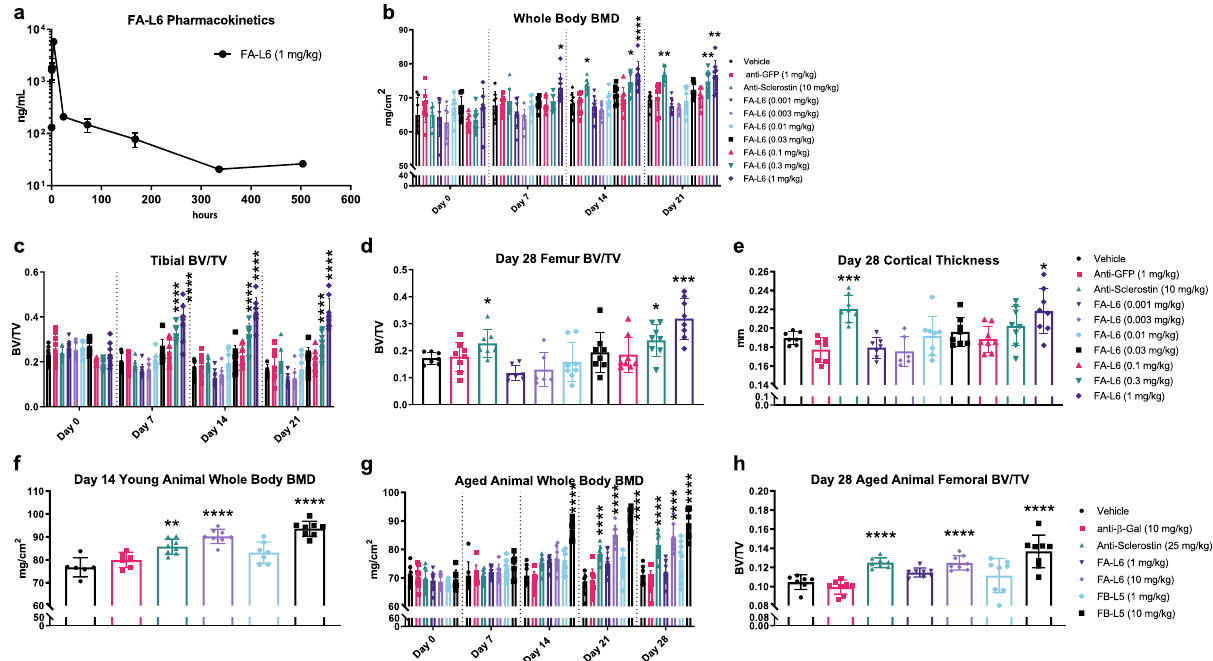
Fig. 5 Wnt mimetic antibodies robustly stimulate bone accrual in naive young and older mice. a Serum concentrations of FA-L6 antibody after intraperitoneal administration, as measured by ELISA over a 21-day period. Each time point represents the average assessed in three animals, with error bars representing the standard deviation of the mean. b – e 8-week-old C57BL6/J female mice were injected bi-weekly for 28 days intraperitoneally with increasing concentrations of FA-L6 antibody and compared to a negative control antibody (anti-GFP IgG 1mg/kg), and a positive control (bi-weekly subcutaneous administration of 10mg/kg anti-sclerostin antibody). b Longitudinal DEXA measurements of whole-body BMD quanti fi ed for days 0, 7, 14, and 21. c Longitudinal micro-CT of proximal tibial bone volume/tissue volume (BV/TV) quanti fi ed on days 0, 7, 14, and 21. d Endpoint distal femoral BV/TV and e mid-shaft cortical thickness were quanti fi ed at day 28. f Whole-body BMD by DEXA in 16-week-old C57BL6/J female mice injected bi-weekly for 14 days with FA-L6 (10mg/kg) or FB-L5 (1 or 10mg/kg) antibody, or a negative control antibody (anti- β -gal 10 mg/kg), or positive control (anti-sclerostin antibody 25mg/kg). g , h 1-year-old C57BL6/J female mice were injected bi-weekly for 28 days intraperitoneally with 1 and 10mg/kg of FA-L6 or FB-L5 antibody or a negative control antibody (anti- β -gal) or positive control (bi-weekly subcutaneous administration of 25mg/kg anti-sclerostin antibody). g Longitudinal whole-body BMD over time and h day 28 endpoint distal femoral BV/TV measurements are shown. a Graph represents mean ± SD, n = 3 mice. b – h Bar graphs represent mean values ± SD. Statistical signi fi cance was determined by two-way ANOVA for b , c , g and one-way ANOVA for all others (* p < 0.05, ** p < 0.01, *** p < 0.001, **** p < 0.0001) where the following letters de fi ne groups (a = Vehicle, b = Anti-Sclerostin, c = FA-L6 (0.3mg/kg), d = FA-L6 (1mg/kg), e = FA-L6 (10mg/kg), f = FB-L5 (10mg/kg)). b Day 7, a vs. d, p = 0.041; Day 14, a vs. b, p = 0.032, a vs. c, p = 0.0412, a vs. d, p ≤ 0.0001; Day 21, a vs. b, p = 0.0019, a vs. c, p = 0.0092, a vs. d, p = 0.0024. c Day 7, a vs. c, p ≤ 0.0001; a vs. d, p ≤ 0.0001. Day 14, a vs. c, p ≤ 0.0001; a vs. d, p ≤ 0.0001. Day 21, a vs. c, p ≤ 0.0001; a vs. d, p ≤ 0.0001. d a vs. b, p = 0.0183, a vs. c, p = 0.0141, a vs. d, p = 0.0002. e a vs. b, p = 0.001, a vs. d, p = 0.0401. f a vs. b, p = 0.007, a vs. e, p ≤ 0.0001, a vs. f, p ≤ 0.0001. g Day 14, a vs. f, p ≤ 0.0001; Day 21, a vs. b, p ≤ 0.0001, a vs. e, p ≤ 0.0001, a vs. f, p ≤ 0.0001; Day 28, a vs. b, p ≤ 0.0001, a vs. e, p ≤ 0.0001, a vs. f, p ≤ 0.0001. h a vs. b, p ≤ 0.0001, a vs. e, p ≤ 0.0001, a vs. f, p ≤ 0.0001. n = 8